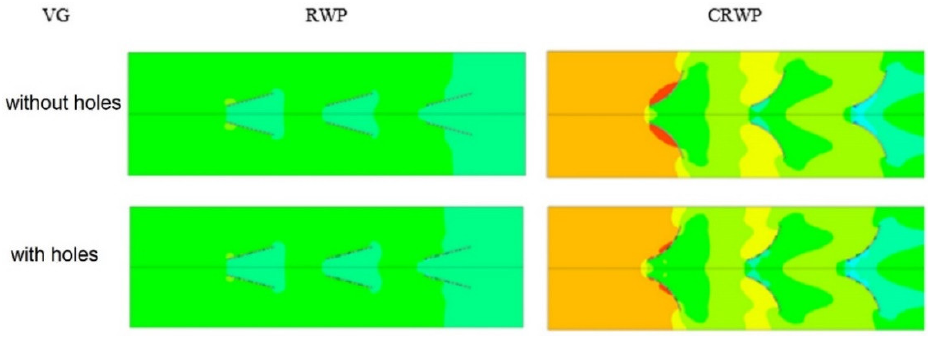
Figure 10. Pressure distribution in streamflow direction with mounting VG.